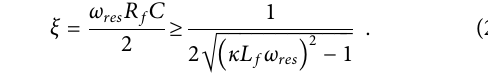
Table 2 . L T = 6 mH, C = 18 uF, R f = 1